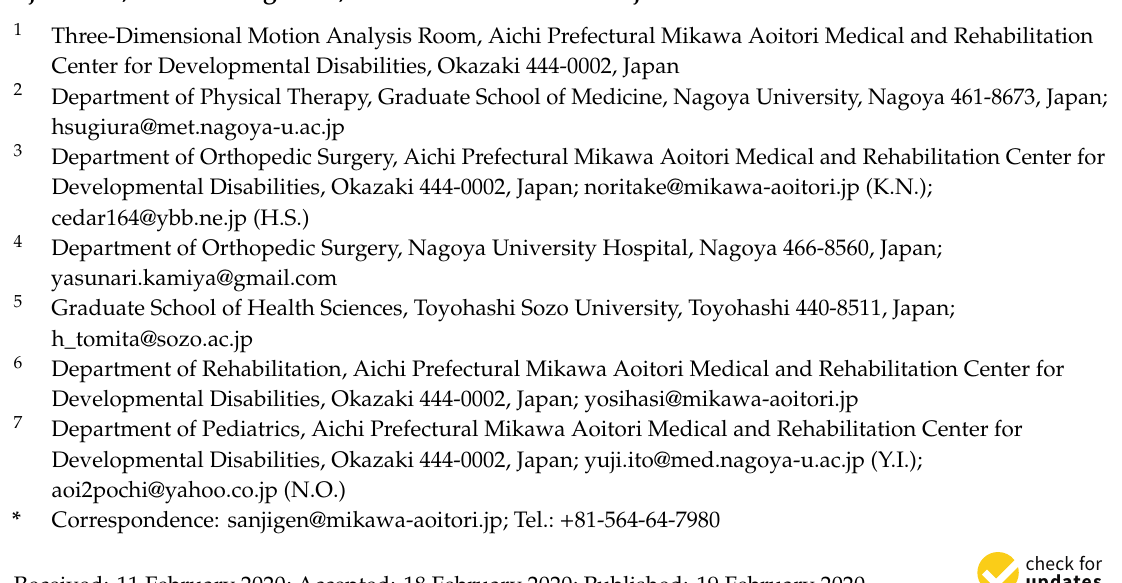
Table 3. Correlation between GDI, FTSST, and gait speed according to GMFCS levels I and II ( n =